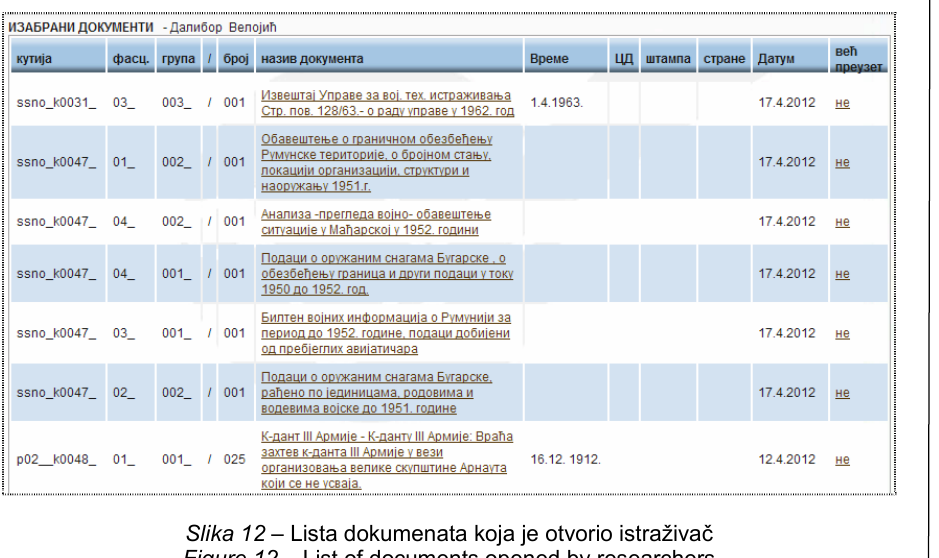
Figure 12 – List of documents opened by